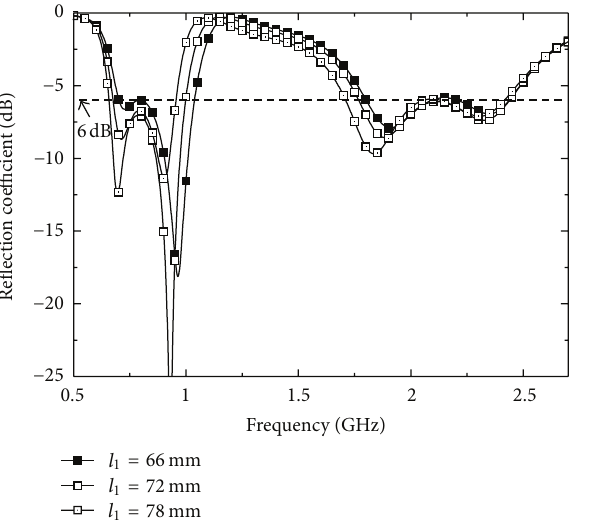
𝑙 F 4: Simulated re�ection coe�cients relative to changes in the . total length of the long radiator 𝑙𝑙 1